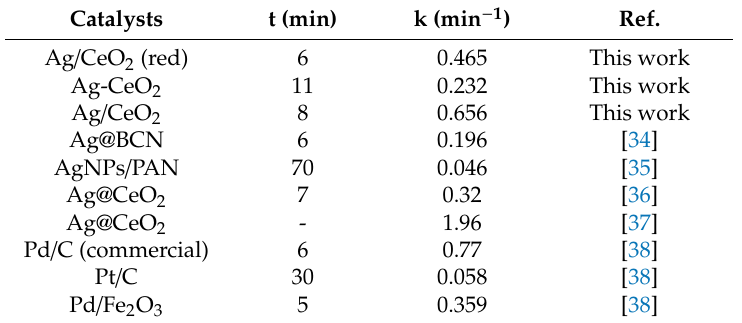
Table 3. The activity of noble metal catalysts in reduction of nitroarenes with NaBH 4